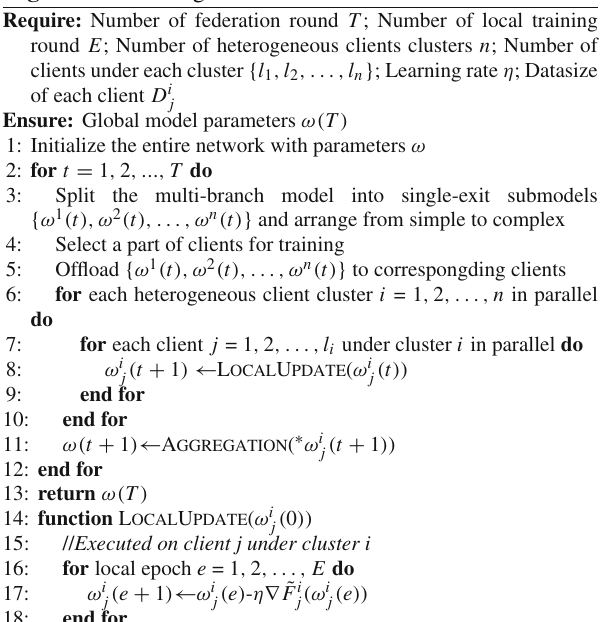
Algorithm 1 Hetergeneous